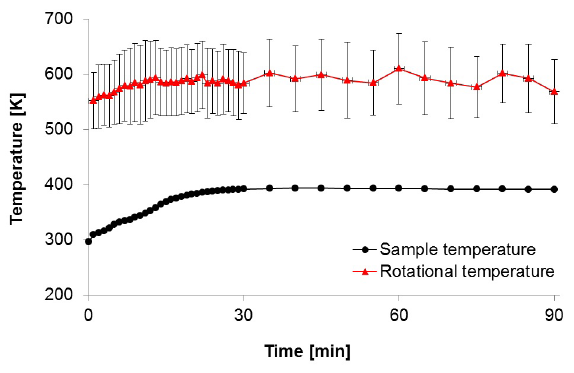
Figure 3: Time dependence of sample temperature and rotational plasma temperature, one sample from Process 1.